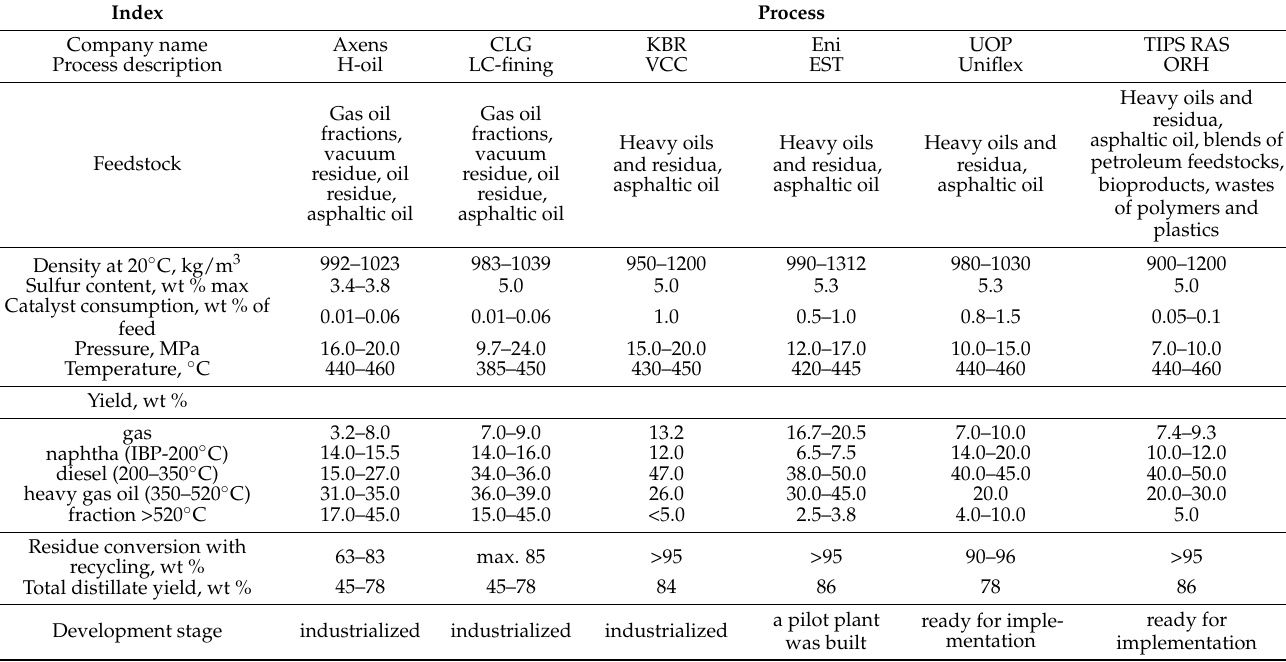
Table 6. Characteristics of modern hydrogenation